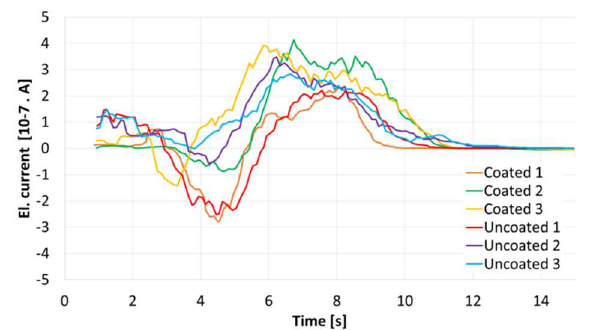
Fig. 6. Electrostatic probe measurement .